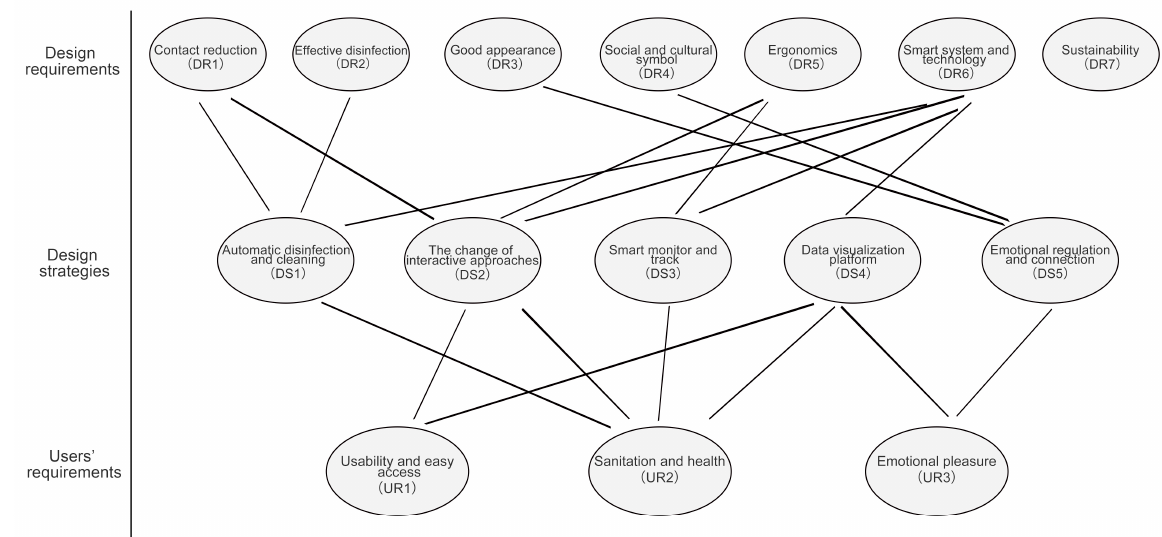
Figure 8. The links of design strategies with URs and DRs.